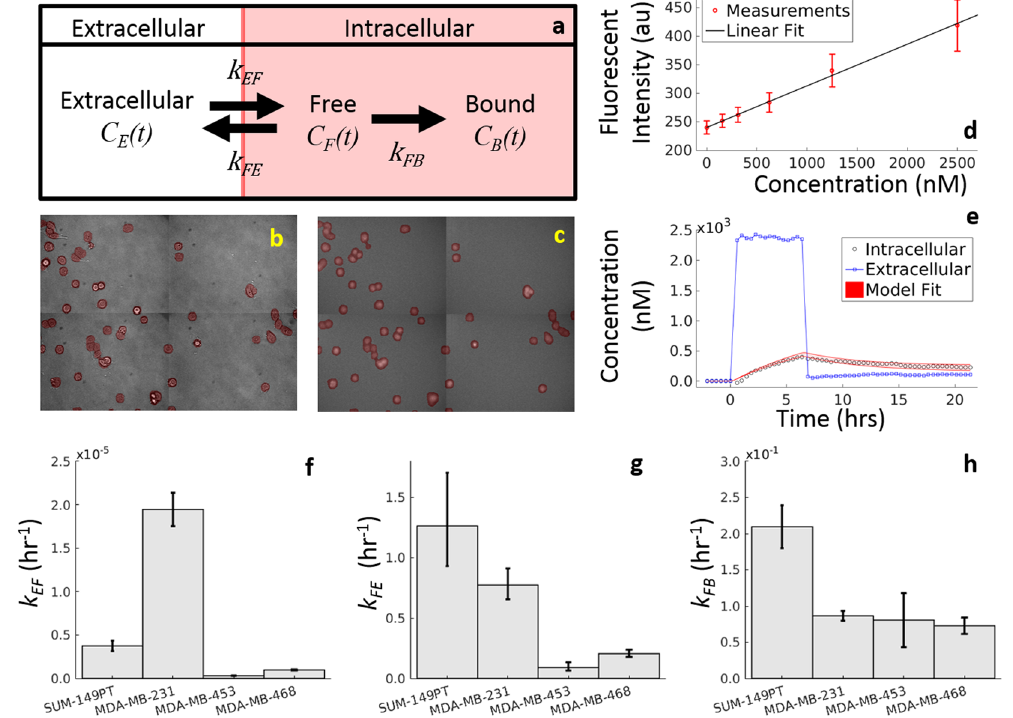
Figure 2. Overview of Doxorubicin Compartment Modeling. Doxorubicin pharmacokinetics is described with a three compartment model, illustrated in ( a ) and described by Eqs (1–3). To parameterize this model, each cell line is serially imaged via brightfield ( b ) and fluorescent microscopy ( c ) to monitor doxorubicin concentration over time. Images are separated into extracellular and intracellular (red overlay) compartments. As fluorescence intensity is proportional to doxorubicin concentration ( d ), the image intensities are converted into concentration, and extracellular and intracellular concentration timecourses are extracted from these images ( e ). Finally, the model is fit to these timecourses ( e ), and the model fit with 95% confidence interval are overlaid on the data. Experimentally-derived model parameter values with 95% CIs are reported for each TNBC cell line investigated ( f – h